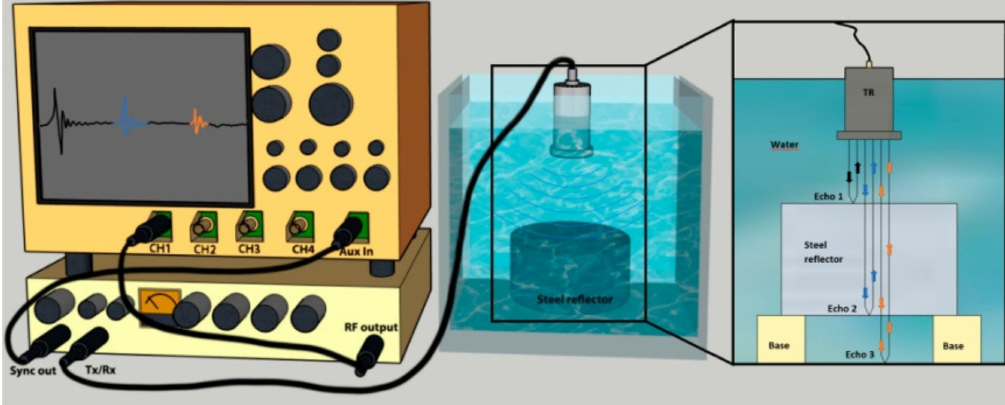
Figure 3. Experimental set-up for pulse-echo